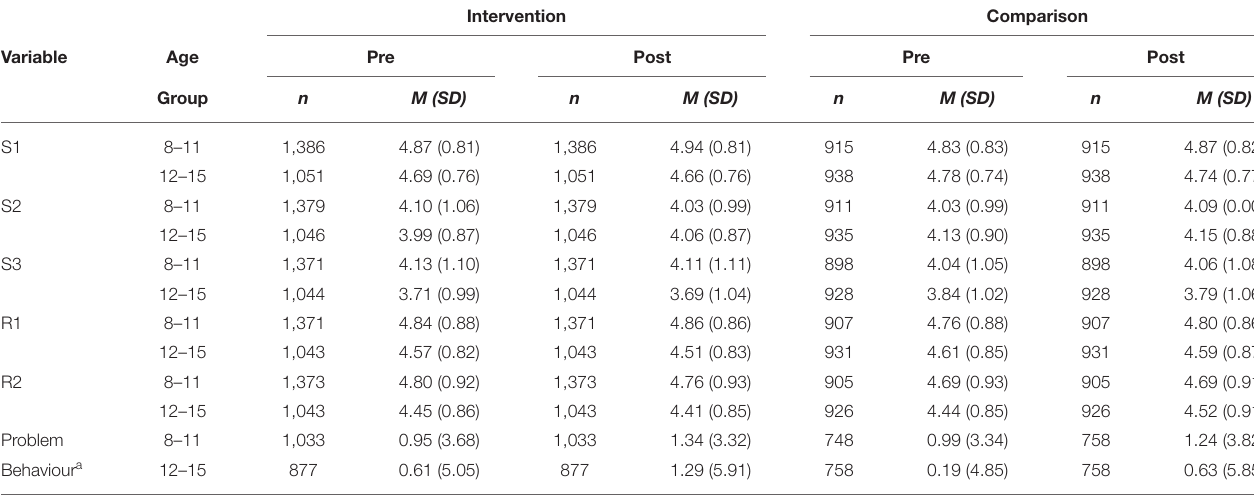
TABLE 7 | SEL and problem behavior in both age groups separately in pre- and post-tests and in intervention and comparison groups. Intervention